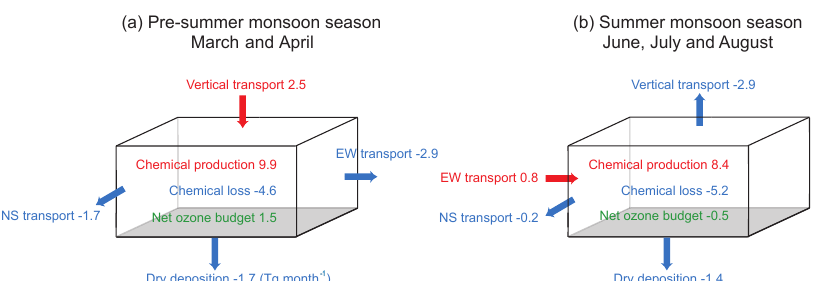
Figure 4. Schematic diagram of the lower-tropospheric ozone budget integrated over the Indian terrestrial land in the pre-summer monsoon season (March and April) and in the summer monsoon season (June, July, and August). Values are in unit of Tgmonth − 1